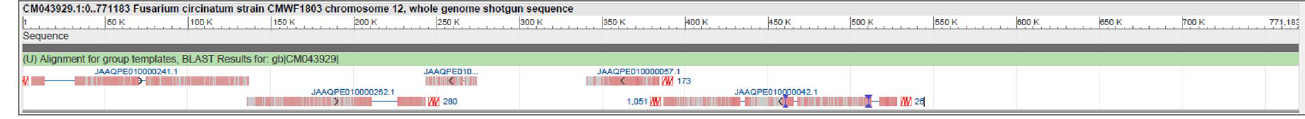
Figure 1. Localization of the scaffolds of F.circinatum strain NRRL 25331 on the 12th chromosome of the representative genome of Fusarium circinatum strain CMWF1803. Black bar—reference se- quence of F.circinatum 12th chromosome CMWF1803 strain with coordinates of the sequence. Blue letters—names of F.circinatum strain NRRL 25331 scaffolds. Grey/red boxes—scaffolds of